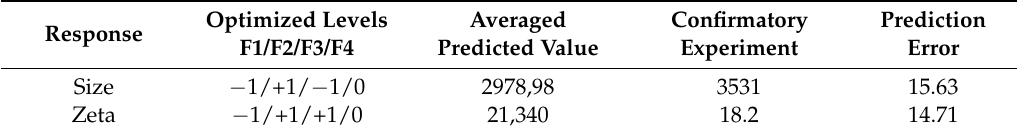
Table 6. Optimized parameters by regression analysis.